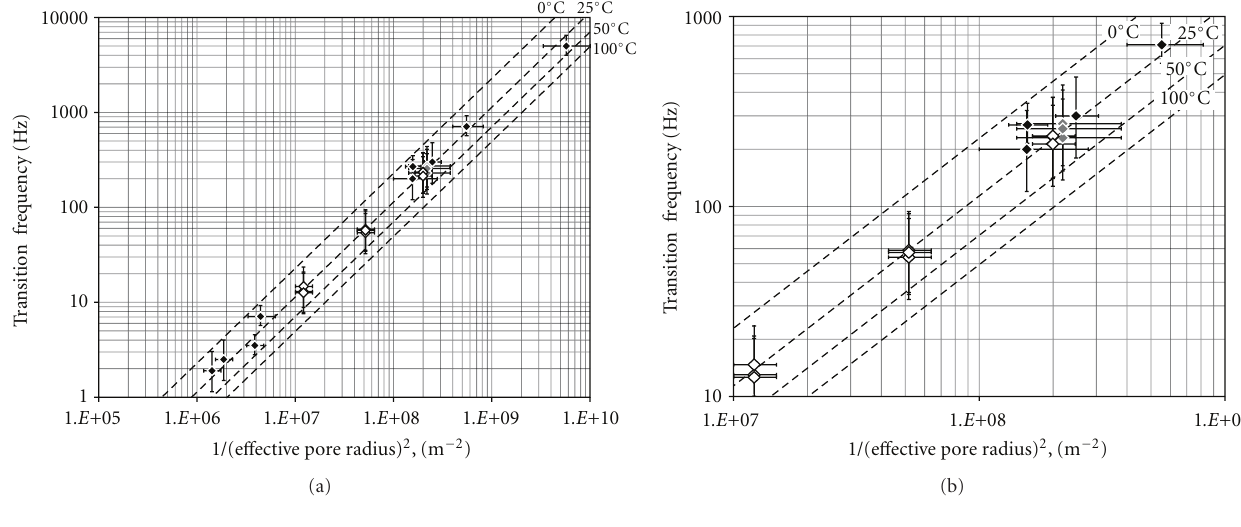
Figure 9: The electrokinetic transition frequency as a function of the inverse square characteristic pore size (a) in full and (b) at expanded scale. Black symbols, previous data for capillary tubes, filters frits, and rocks, Figure 6 of [19]; grey symbols, Ottawa sand measured at 24.0 ◦ C ± 0.8 ◦ C; open symbols, glass bead packs. The dashed lines represent the theoretical result [19] at four di ff erent